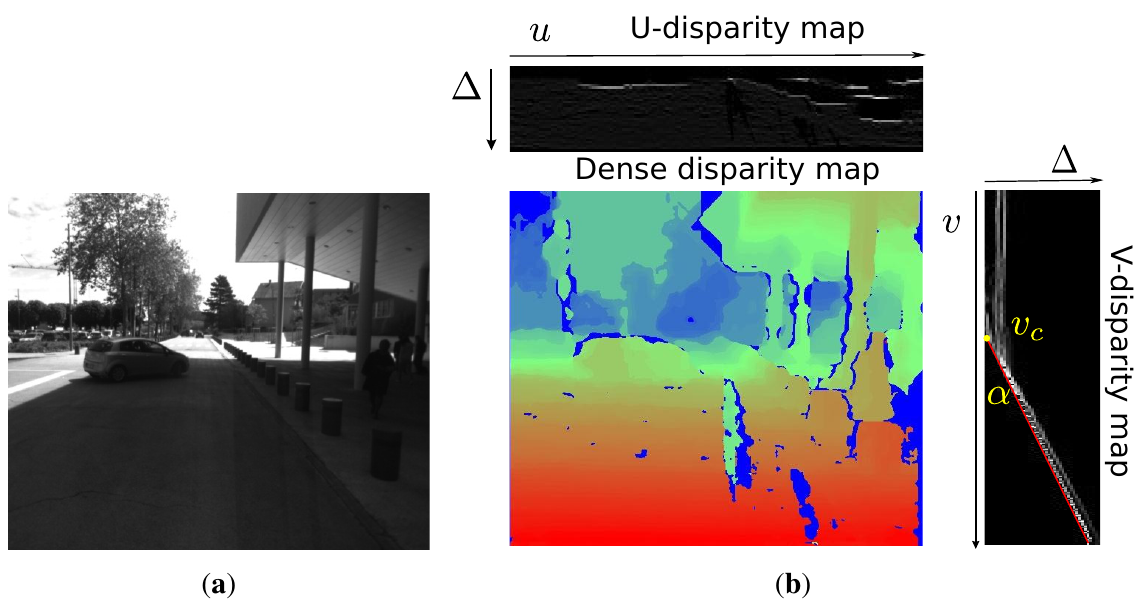
Figure 3. Stereo measurements. ( a ) An image of a road scene; ( b ) the dense disparity map and U-V disparity